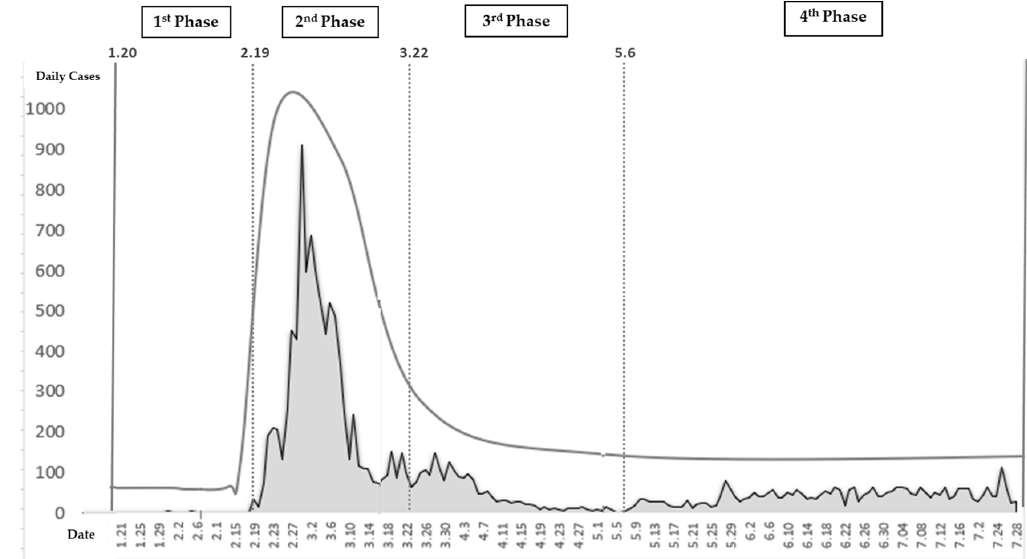
Figure 1. Disaster management process for COVID-19 in Korea. Source: Authors’ Elaboration.